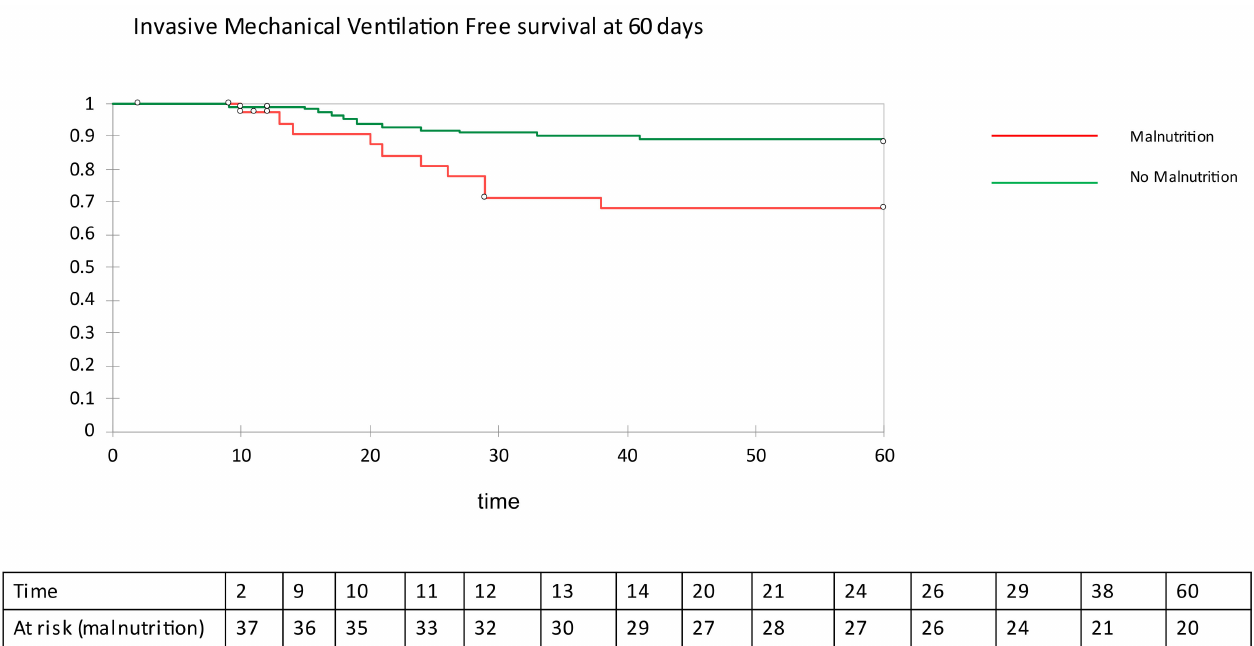
Figure 2. Invasive mechanical ventilation free survival at 60 days.